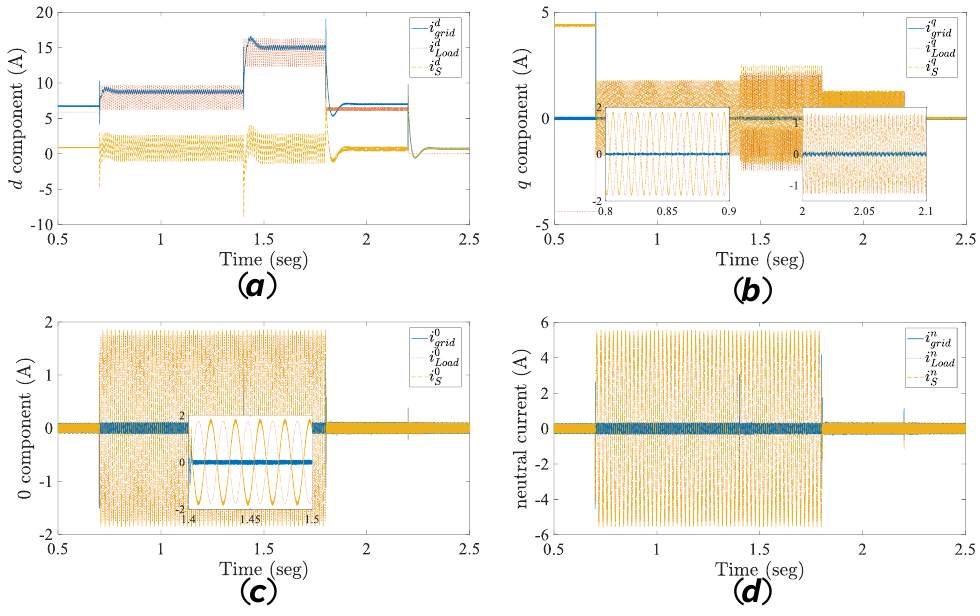
Figure 12. PI controllers’ dynamical performance comparison: ( a ) i d s , ( b ) i q s , ( c ) i 0 s , and ( d ) v DC